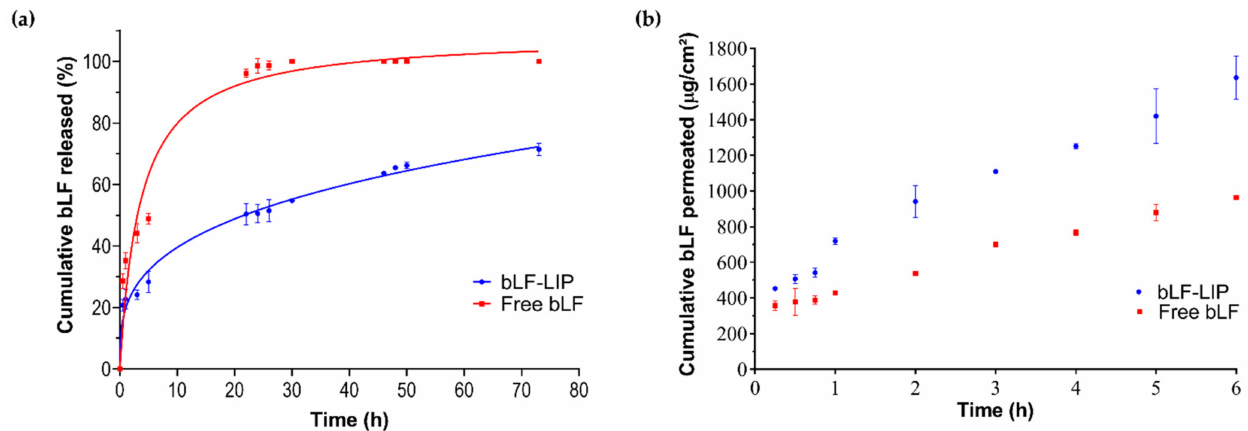
Figure 4. Biopharmaceutical behaviour. ( a ) In vitro release profile of bLF-LIP (Korsmeyer–Peppas equation) against free bLF (hyperbola equation). ( b ) Ex vivo corneal permeation profile of bLF-LIP compared with free bLF and permeation